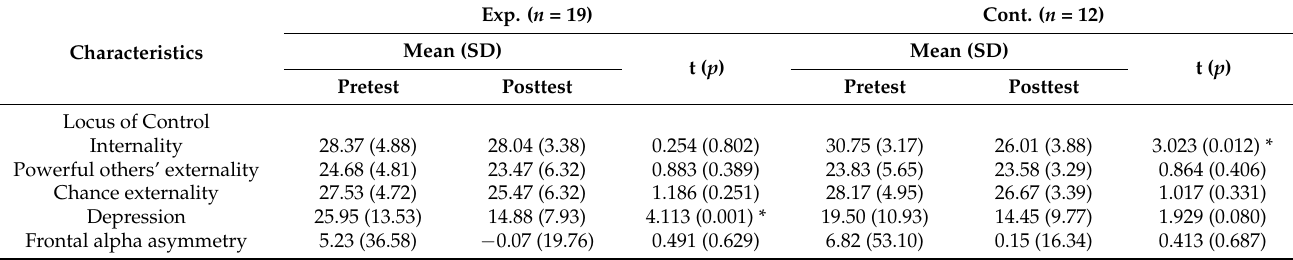
Table 3. Comparison of variables between pre-test and